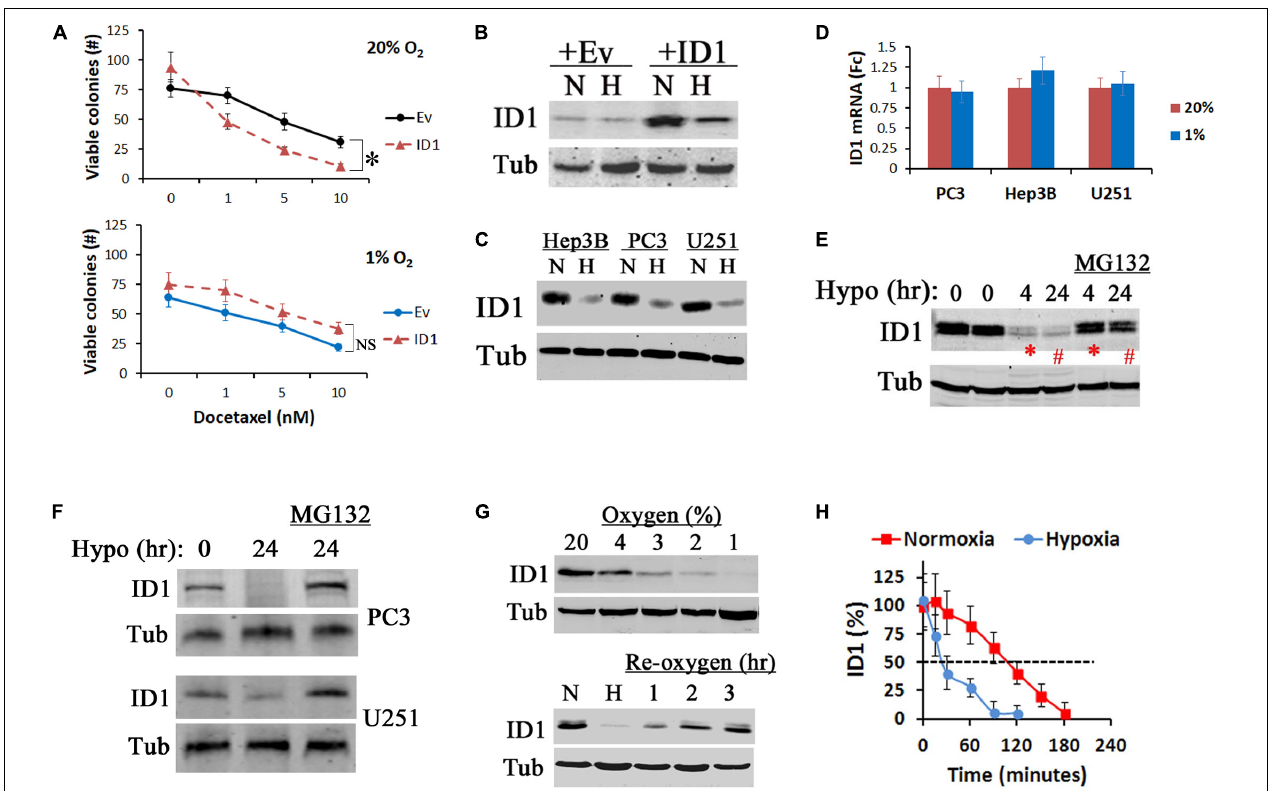
FIGURE 1 | Hypoxia inhibits ID1 proteins. (A) LNCaP cells with stable ID1 (ID1) or empty vector (Ev) overexpression were treated with increasing dose of docetaxel in 20% or 1% O 2 . Cell viability was measured by colony formation assay. ∗ P < 0.05, t -test, n = 3, mean and standard deviation (stdv). (B) LNCaP-Ev and LNCaP-ID1 cells were cultured in 20% (N) or 1% (H) O 2 for 24 h. ID1 and tubulin (Tub) protein levels were determined by western blots. (C,D) Hep3B, PC3, and U251 cells were cultured in 20% (N) or 1% (H) O 2 for 24 h. ID1 and tubulin were determined by western blots (C) . ID1 mRNA levels were determined by qRT-PCR with b-actin as control (D) . (E) Hep3B cells were cultured in 1% O 2 for 4 and 24 h with/without proteasome inhibitor MG132. ID1 and tubulin were measured by western blots. (F) ID1 protein levels in PC3 and U251 cells after 24 h of normoxia, hypoxia, or hypoxia plus MG132. (G) ID1 protein levels after U251 cells were cultured with decreasing concentrations of O 2 for 24 h (top). ID1 proteins after U251 cells cultured in 20% (N), 1% (H) O 2 overnight, or 1% O 2 overnight followed by re-oxygenation in 20% O 2 for the indicated times (bottom). (H) U251 cells were cultured in 20% or 1% O 2 , and treated by cycloheximide to arrest protein synthesis. ID1 protein levels at the indicated times were determined by western